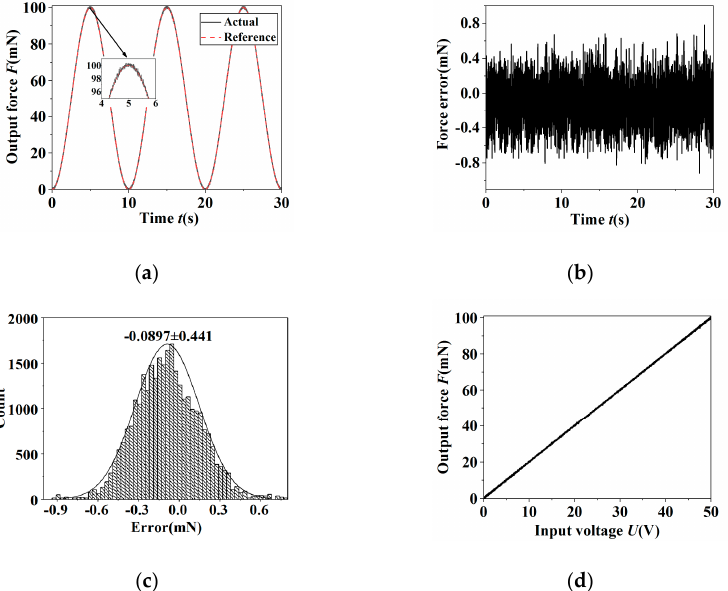
Figure 11. The output results of open ‐ loop control of the sinusoidal signal for the grapping force. ( a ) The reference signal and output response; ( b ) the error; ( c ) the hysteresis curve.